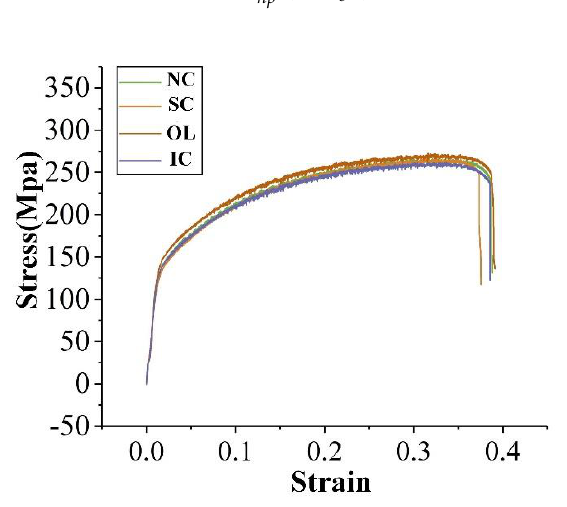
Figure 16. Stress–strain curves of the fourth cooling process.